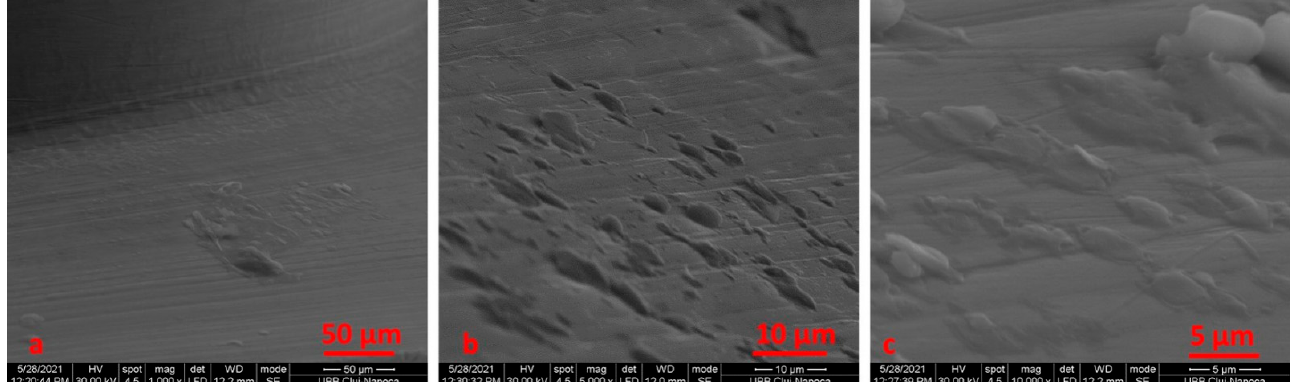
Figure 14. SEM images with mini-implants and SM at ×1000 ( a ), ×5000 ( b ), ×10000 ( c ) magnification. Bacterial colonization on the mini-implant bodies ( a,b,c ).